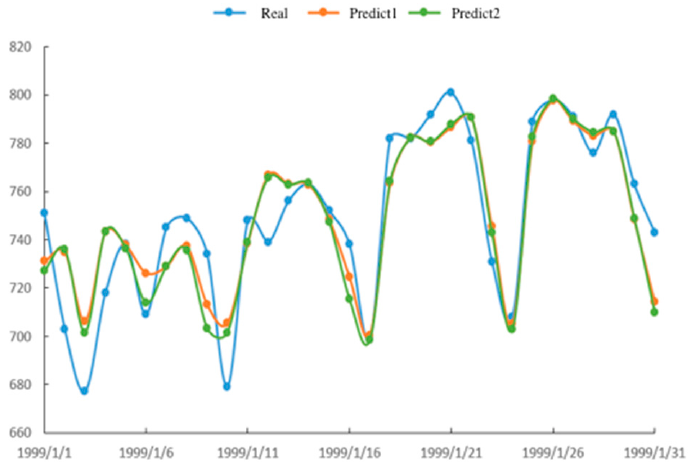
Figure 13. Load curve comparison (Predict 2 is our method).